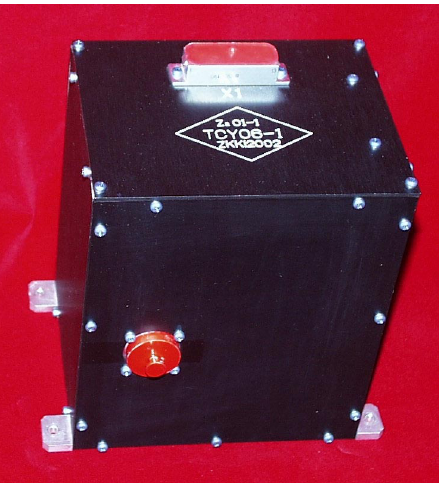
Fig. 1. Flight model of HEPD on board of TC-1.